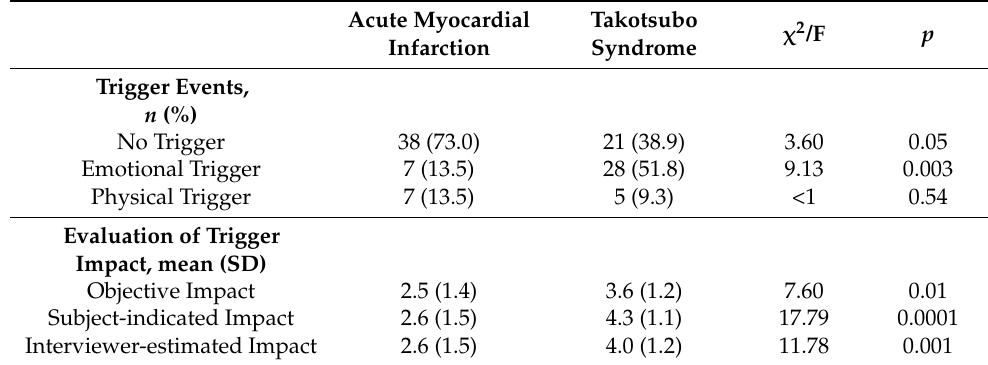
Table 4. Statistical results of the trigger indices reported by the groups.